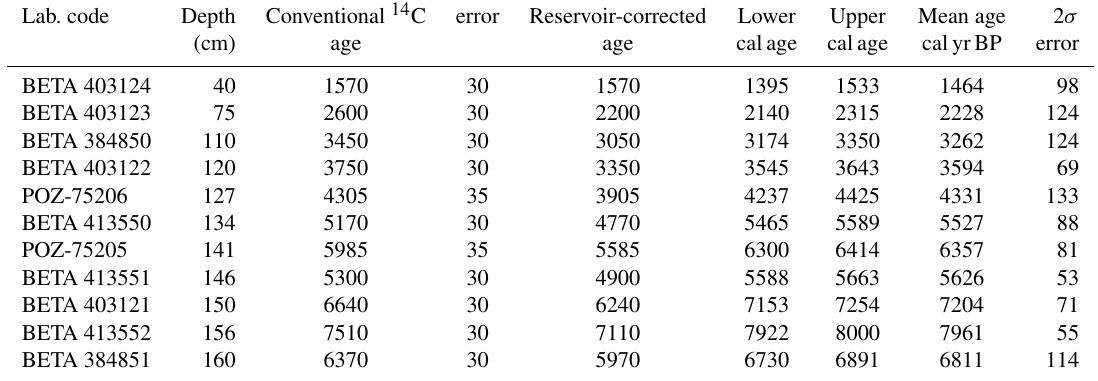
Table 1. Conventional AMS radiocarbon dates and reservoir-corrected and 2 σ range calibrated ages from Sebkha Boujmel (BJM2 core). Lab.